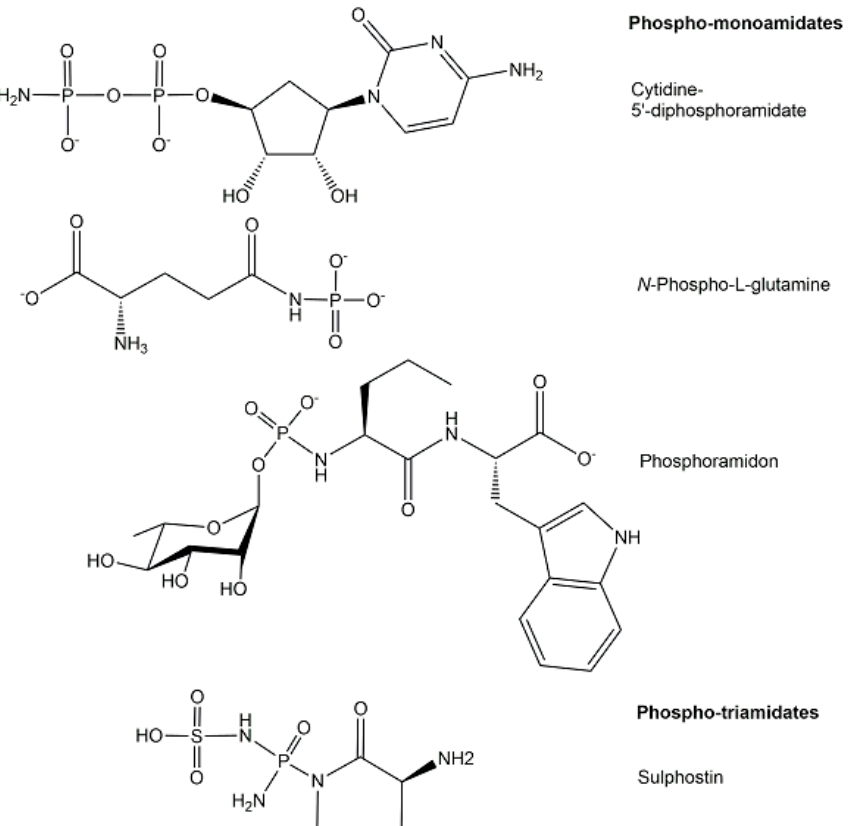
Figure 9. Selected structures of endogenous phosphoramidates from the classes of phosphomono- amidates and phospho-triamidates.